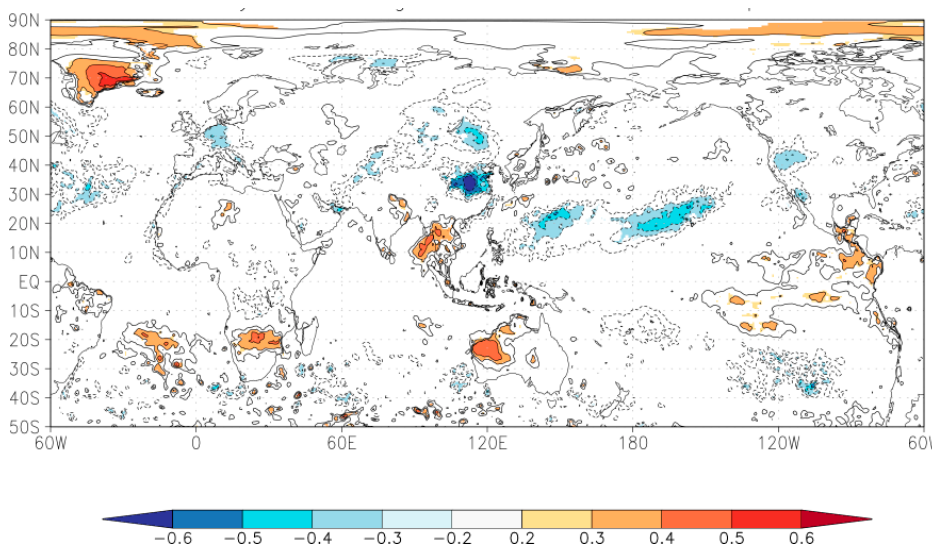
Figure 11. The relationships between tree growth and global sea surface temperature (SST (60 ° W- 120 ° E-60 ° W, 50 ° S-90 ° N), NASA MERRA-2 Tsfc, 1980–2016).